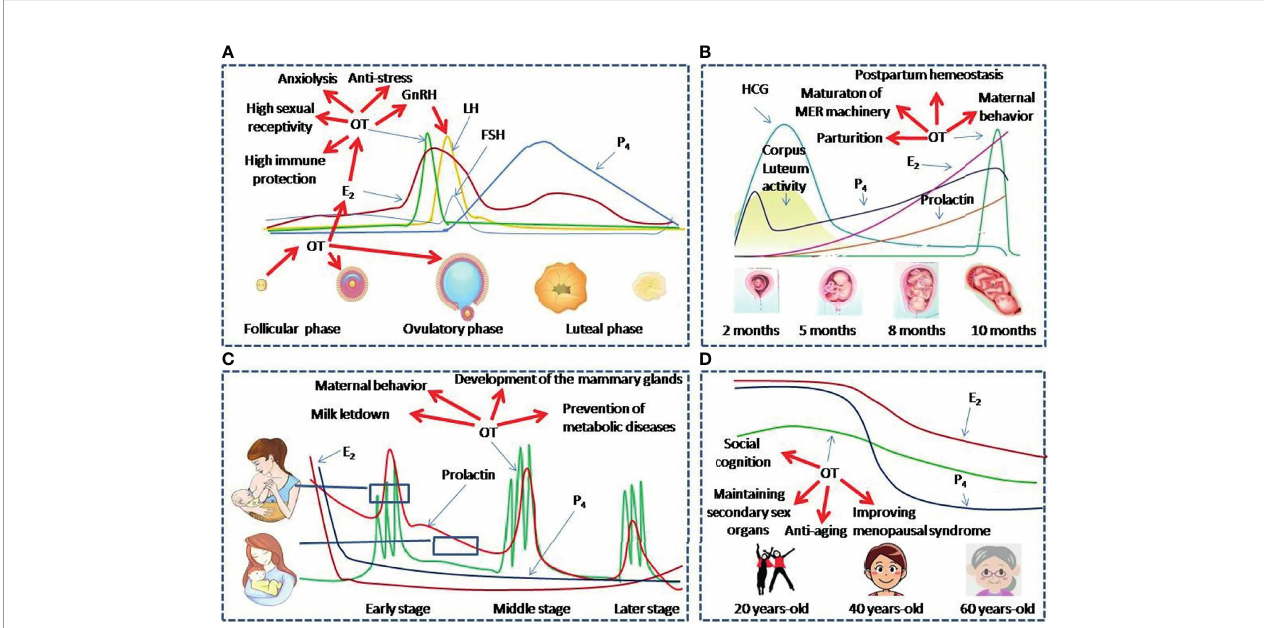
FIGURE 2 | OT functions at different reproductive stages of women. (A – D) Panels show levels and functions of OT and associated reproductive hormones during Menstruation (A) , Pregnancy and parturition (B) , Lactation (C) and Peri-menopausal stage (D) , respectively. E2, estradiol; FSH, follicle-stimulating hormone; GnRH, gonadotropin-releasing hormone; HCG, Human Chorionic Gonadotropin; LH, Luteinizing hormone; MER, the milk-ejection re fl ex; P4,